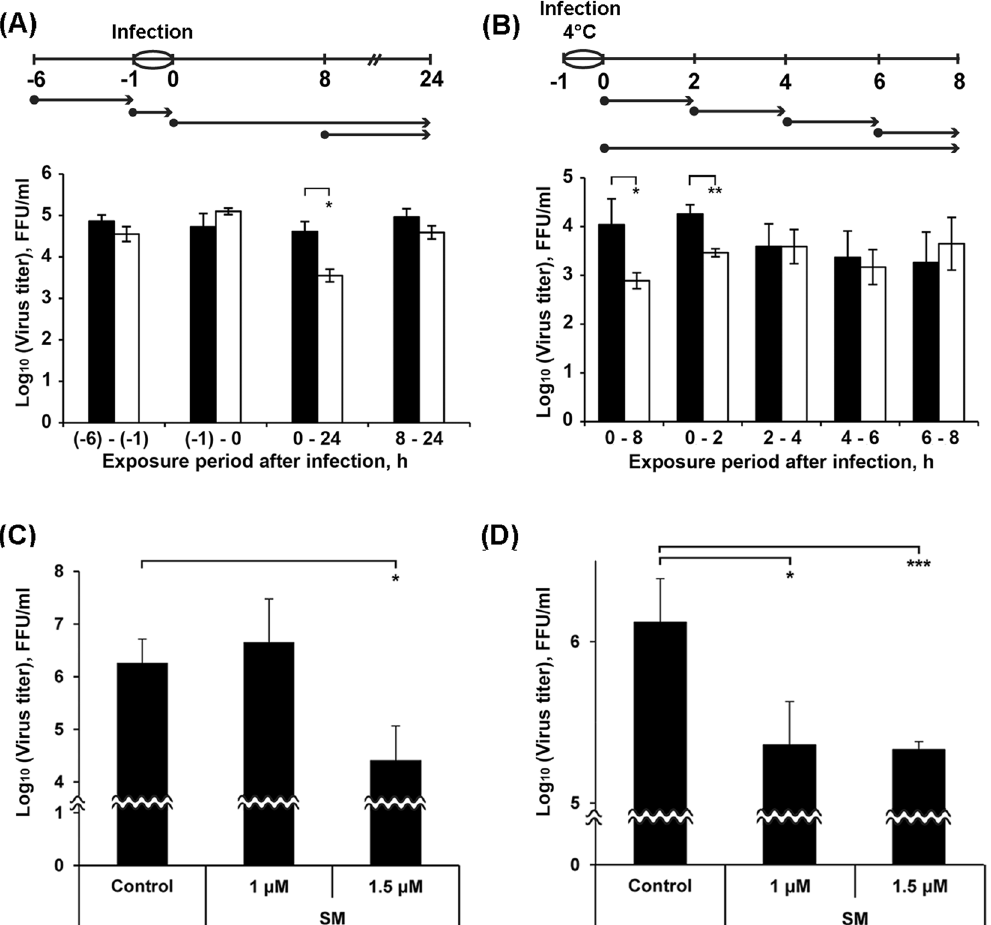
Figure 3. SM inhibits early steps of IVA infection. ( A ) and ( B ) Influence of the time of addition of SM on the virus production in cells. MDCK cells were infected with IVA at MOI 0.01 (A) or 0.001 (B) for 1 h (from -1 to 0 h). SM (1 µ M) was added to cells at the indicate time points ( • ). In ( B ) after each incubation period (shown by arrows) the medium containing SM was replaced by the fresh infection medium. At the time points 24 h p.i. ( A ) and 8 h p.i. ( B ), the viral supernatants were collected and the viral yields were evaluated by FFA. Black columns – the mean viral yield for control cells; white columns – the mean viral yield for cells treated with SM. Data shown represent the mean ± SD of the results of three independent experiments. * p < 0.05, ** p < 0.01. ( C ) SM inhibits binding of IVA to MDCK cells. MDCK cells were pre-chilled at 4 °C for 1 h and infected with IVA at MOI 0.01 followed by supplementation with SM (1 or 1.5 μ M). After 3 h of incubation at 4 °C, cells were washed with PBS and overlaid with fresh medium. At 24 h p.i., viral supernatants were collected and the virus yields were determined by FFA. ( D ) SM inhibits penetration of IVA into MDCK cells. MDCK cells were pre- chilled at 4 °C for 1 h and incubated with virus (MOI 0.1) at 4 °C for 3 h. SM (1 or 1.5 μ M) was then added to the cells and incubated for 60 minutes at 37 °C. Following inactivation and the neutralization of unpenetrated virus using acidic and alkaline PBS, respectively, cells were washed with PBS and overlaid with fresh medium. At 24 h p.i. viral supernatants were collected and the virus yields were determined by FFA. For ( C ) and ( D ): Control – untreated infected MDCK cells. Error bars represent the standard deviation of three independent experiments performed in triplicate. P-value: * < 0.05; *** <